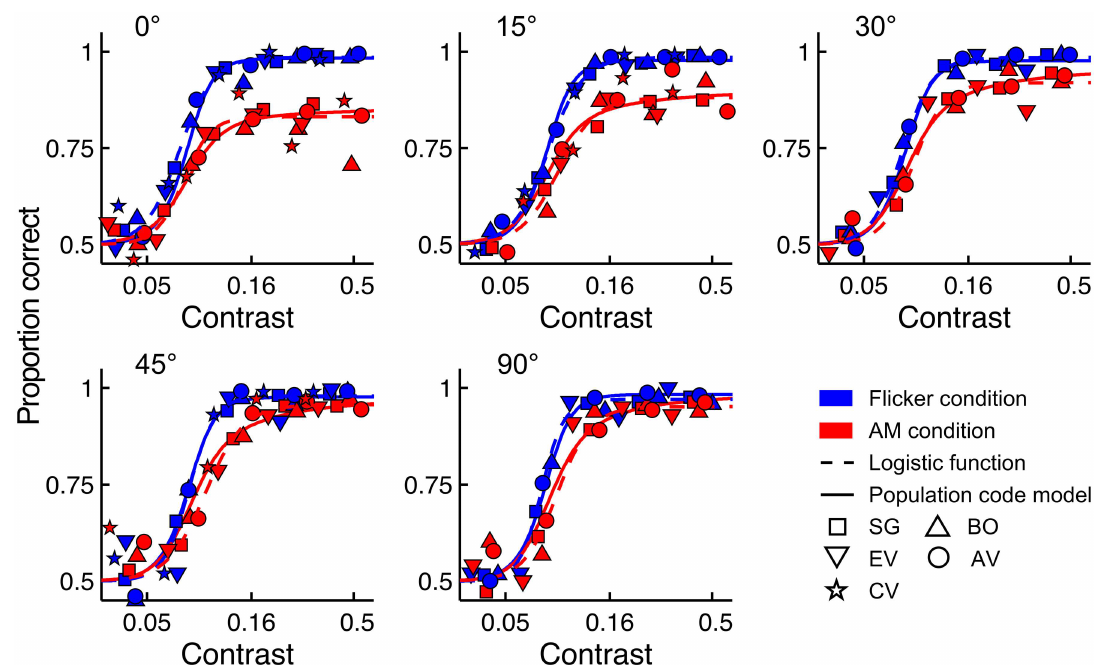
Fig 2. Orientation tuning of AM masking and model fits. The pooleddata of the five observers are shown for each orientationlevel. Red and blue symbols represent the AM and Flicker conditions, respectively. Dashed lines depict the best- fitting logistic psychometric function, while full lines represent the best-fitting contrast normalization model. Symbols denote different observers.